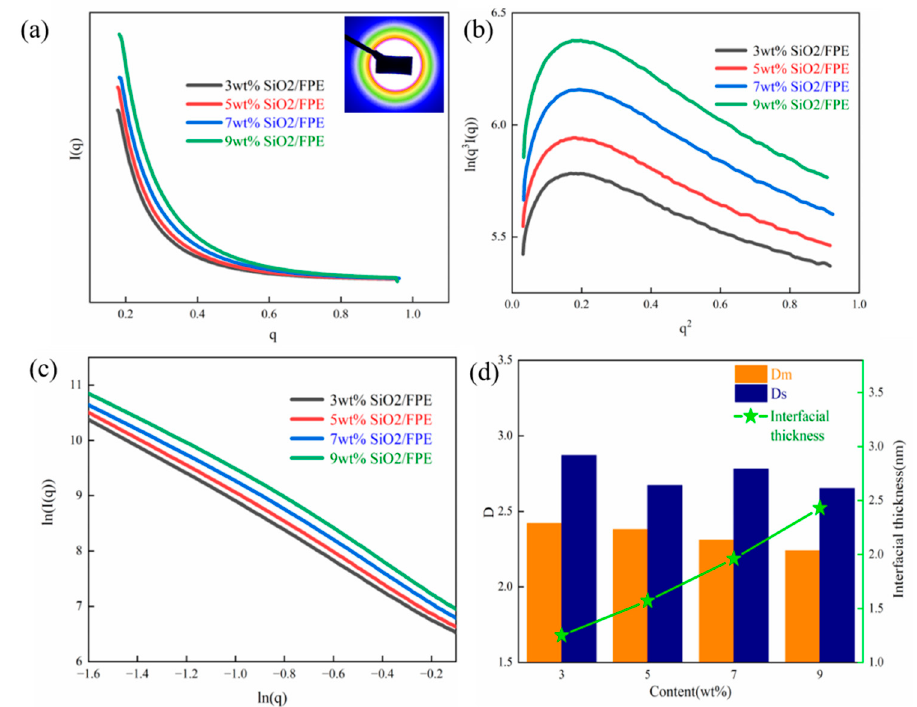
Figure 3. ( a ) The SAXS scattering intensity curves of the SiO 2 /FPE composite film with different concentrations. ( b ) Porod curves of the SiO 2 /FPE composite film. ( c ) Typical ln (I(q)) versus ln (q) plots of the SiO 2 /FPE composite film. ( d ) The fractal dimension and interfacial thickness of the SiO 2 /FPE composite